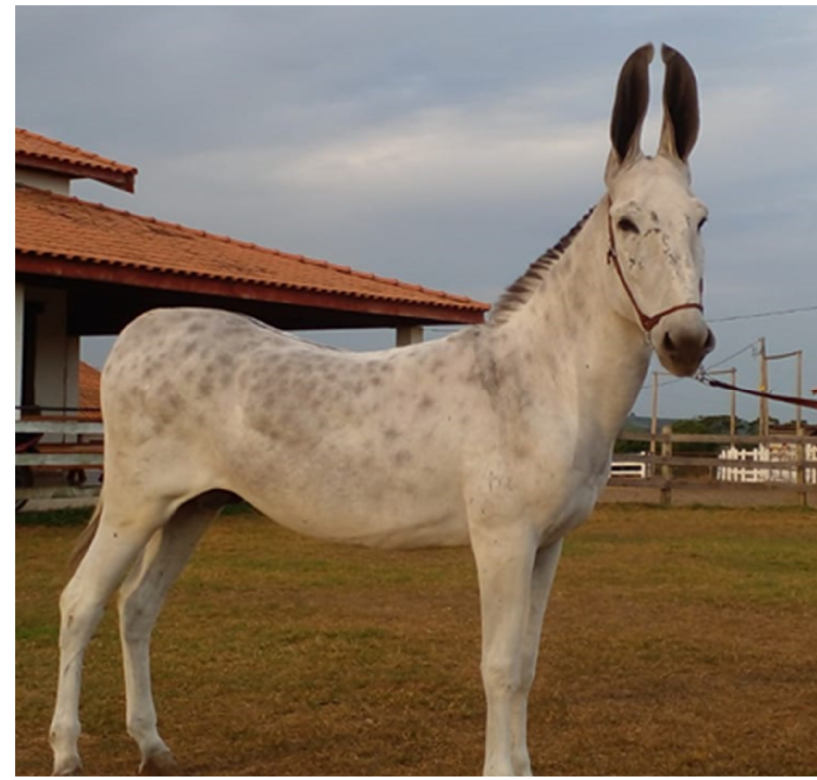
Figure 1. A donkey Pega breed, 8 years old, male.